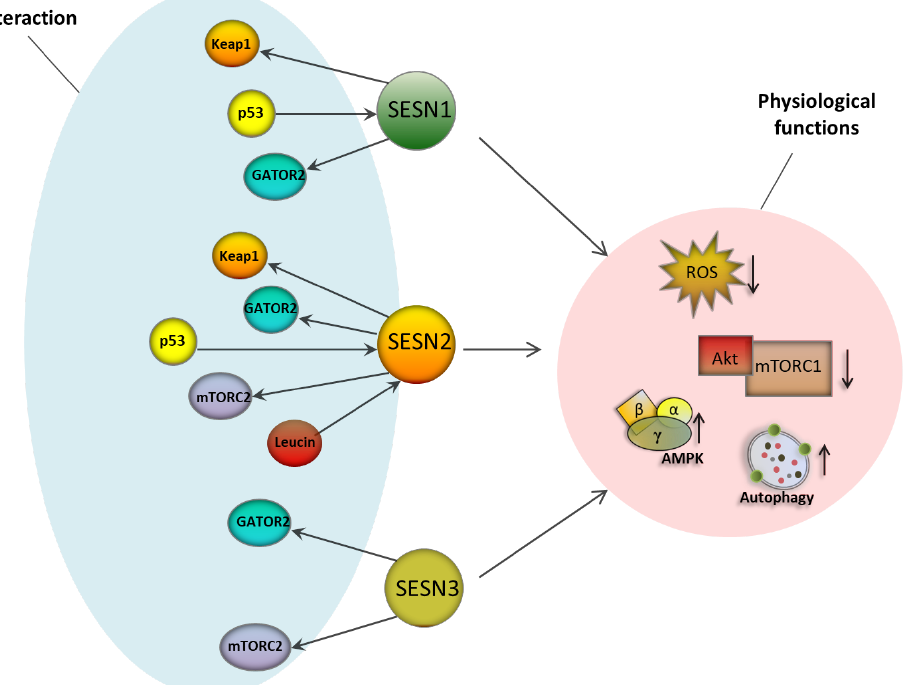
Figure 2. Similarity and differences between members of the sestrin family. SESN1, SESN2 and SESN3 activate antioxidant and pro-autophagic responses by modulating mTORC1 and AMPK signaling pathways, as well as through a positive impact on major antioxidant effectors such as Srxs and Prxs (through mechanisms poorly identified) [37,56,64]. However, some di ff erences between SESNs occur at a biochemical level. Indeed, some of them directly interact with specific e ff ectors. SESN1 and SENS2 (but not SESN3) interact with Keap1 to promote its autophagic degradation [62]. All three SESNs interact with GATOR2 to negatively regulate mTORC1 [54,62,68]. SESN1 and SESN2 are activated